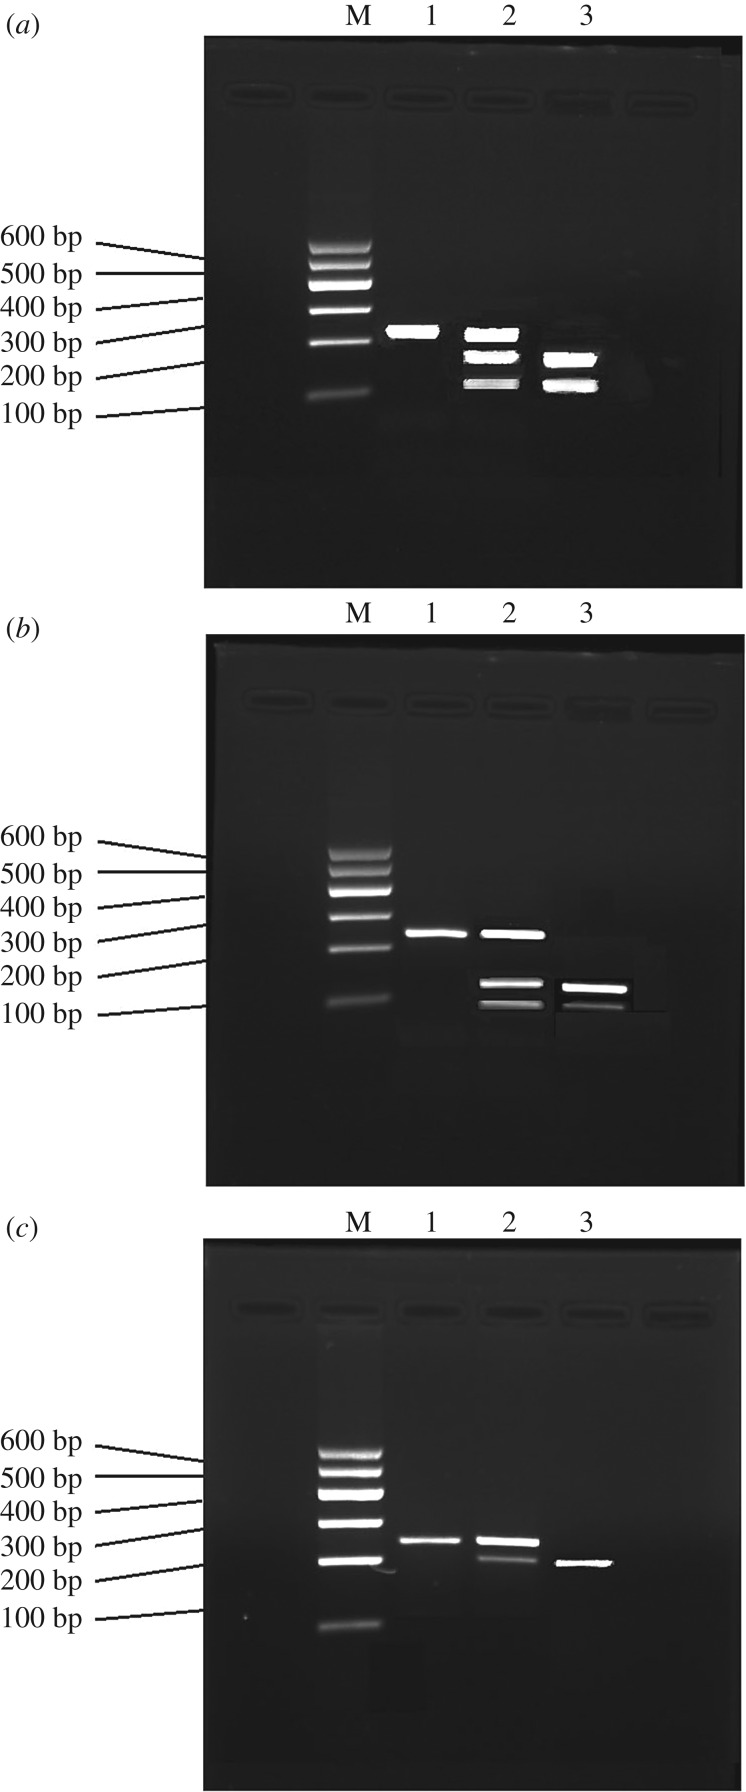
Agarose gel electrophoresis results of SIRT1 gene loci. (a) Electrophoresis pattern of the polymorphism genotype in the rs3818292 locus of the SIRT1 gene. (b) Electrophoresis pattern of the polymorphism genotype in the rs4746720 locus of the SIRT1 gene. (c) Electrophoresis pattern of the polymorphism genotype in the rs10823108 locus of the SIRT1 gene. M denotes marker. 1, 2 and 3 indicate GG genotype, AG genotype and AA genotype, respectively.